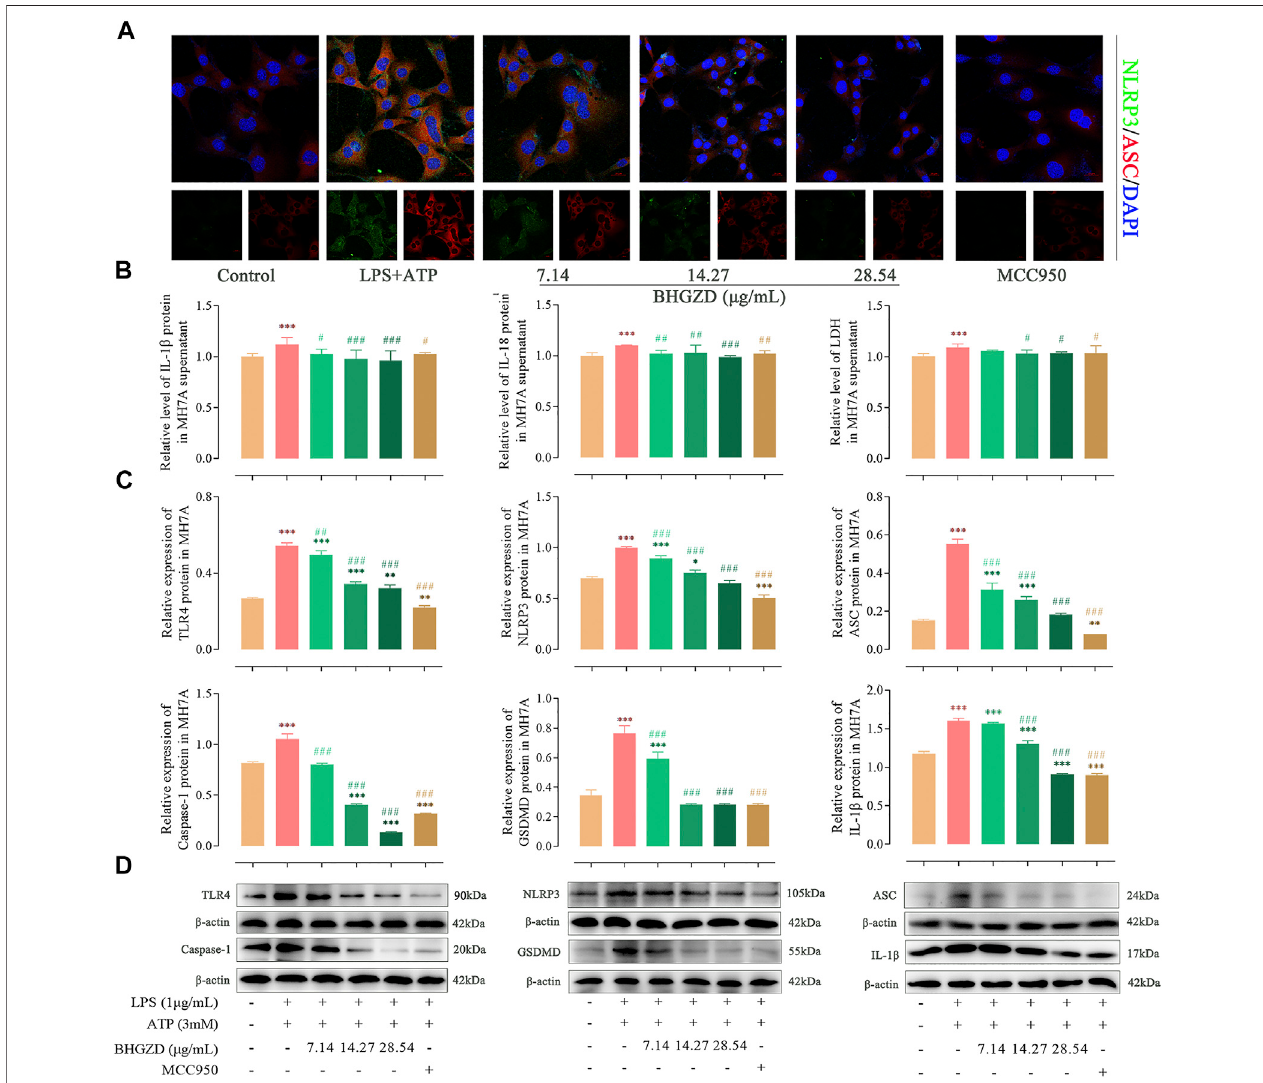
FIGURE 5 | Inhibitory effects of BHGZD on the TLR4 – mediated NLRP3 in fl ammasome activation in LPS/ATP – induced MH7A cells. (A) The expression of NLRP3 and ASC proteins was measured by immuno fl uorescence staining and confocal microscopy in MH7A cells (NLRP3 FITC green, ASC CY3 red, DAPI blue; scale bar represents 20 μ m). (B) The secretions of IL-1 β , IL-18, and LDH release in MH7A cells were evaluated by ELISA. (C ∼ D) The expression levels of TLR4, NLRP3, ASC, caspase-1, GSDMD, and IL-1 β in MH7A cells were measured by Western blotting. *, **, and ***, p < 0.05, p < 0.01, and p < 0.001, respectively, in comparison with the normal control group; #, ##, and ###, p < 0.05, p < 0.01, and p < 0.001, respectively, in comparison with the LPS/ ATP – induced model group.